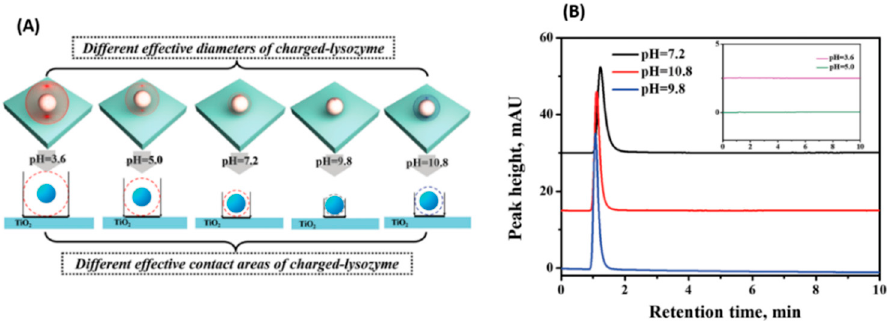
Figure 2. ( A ) Schematic diagram of the effective diameter of charged lysozyme, and the effective contact area of charged lysozyme with TiO 2 under different pH conditions. ( B ) HPLC retention behavior of lysozyme under different pH conditions passing through the imprinted home-made TiO 2 column. Reprinted from Ref. [42] with permission from Wiley.